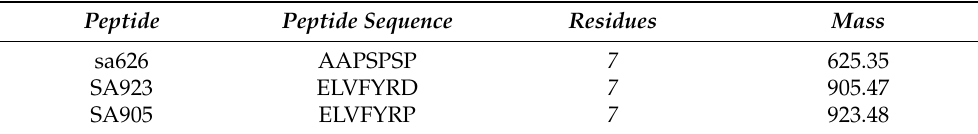
Table 2. List of peptides with their sequences derived using de novo sequencing